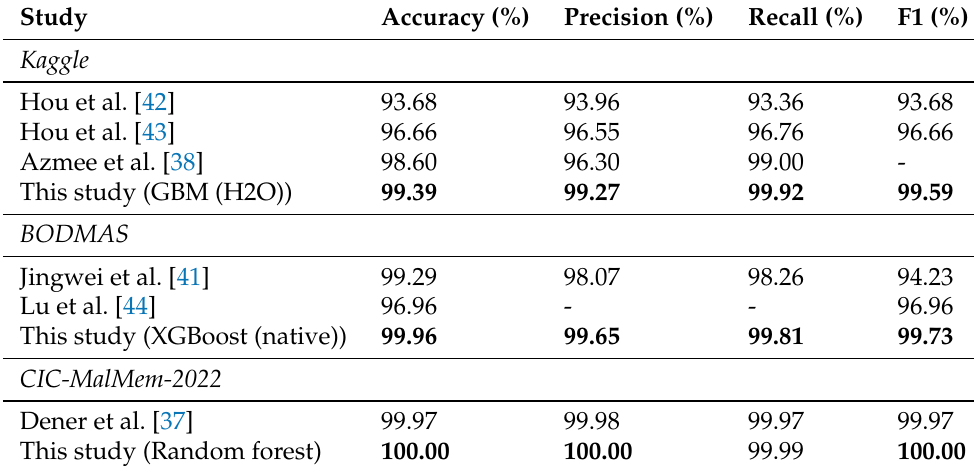
Table 9. Performance comparisons over existing studies. The best performance value on each dataset is shown in